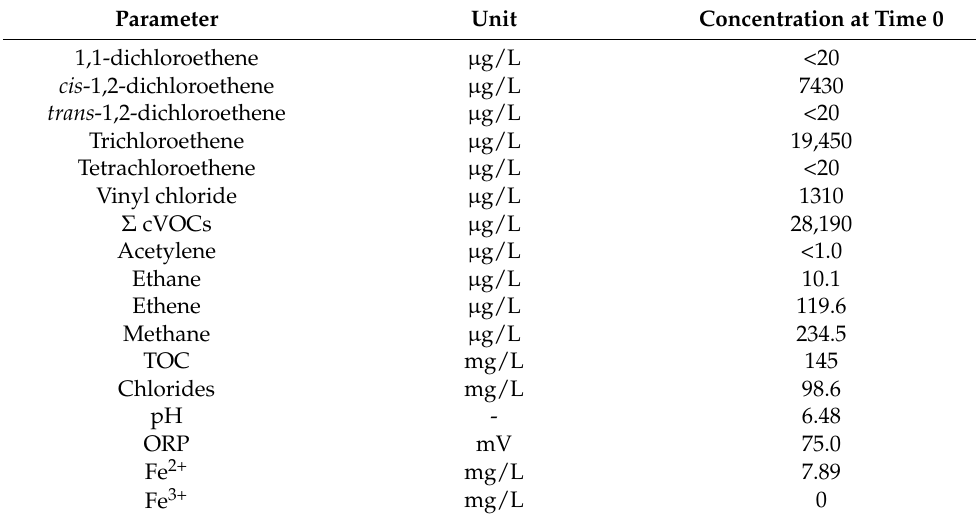
Table 1. Concentrations of all parameters of groundwater used for lab